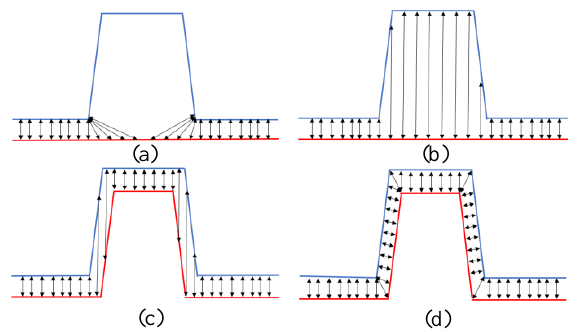
Figure 2. Neighboring points search: (a) is the wrong way to search for neighboring points in 3D direction, (b) is the correct way to search neighboring points in horizontal direction, (c) is the wrong way to search for neighboring points in horizontal direction, (d) is the correct way to search for neighboring points in 3D